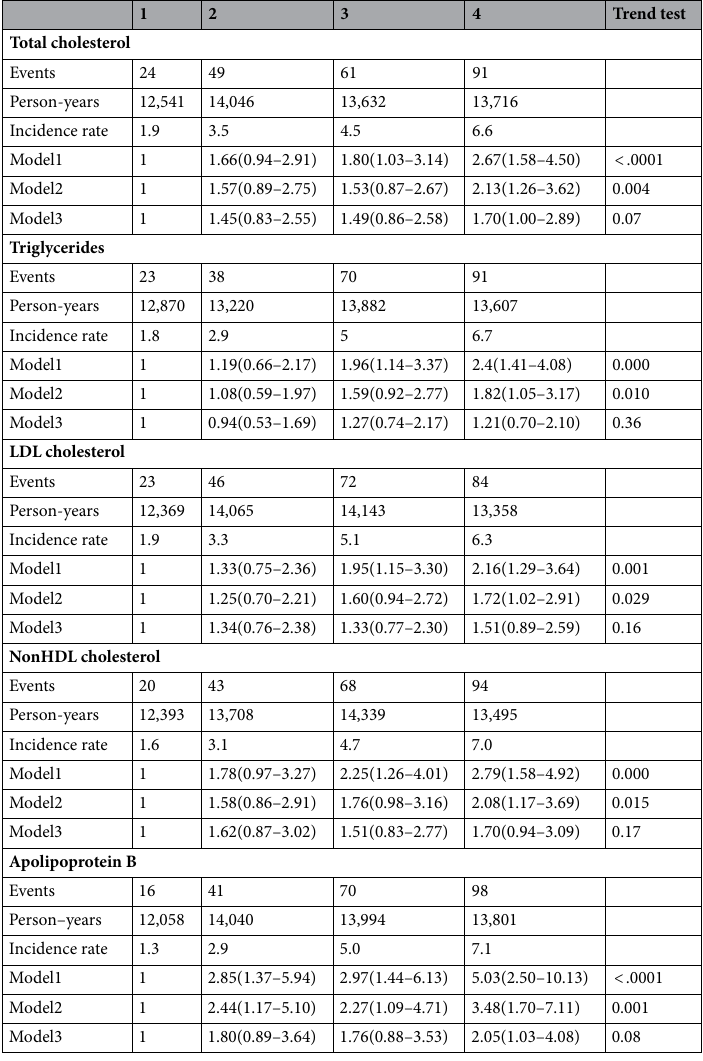
Table 2. Hazard ratios (and 95% CI values) of cardiovascular disease risk during a median 13.3 years of follow-up according to baseline lipid profiles in TwSHHH 2002. Incidence rates are presented per 1000 person-years; Model 1: adjusted for age groups (20–64/ ≥ 65 years old) and sex. Model 2: as for model 1 plus body mass index (18.4/18.5–23.9/24.0–26.9/ ≥ 27 kg/m2), current smoker (yes/no), alcohol drinking (yes/no), marital status (single, divorced or separated/Living with spouse), regular exercise habit (yes/no),education level (9 years/at least 9 years), income level (monthly income level < 40,000, ≥ 40,000 New Taiwan Dollars). Model 3: as for model 2 plus baseline hypertension (yes/no), diabetes mellitus (yes/no), menopause(yes/no), family history of CVD (yes/no), and hsCRP